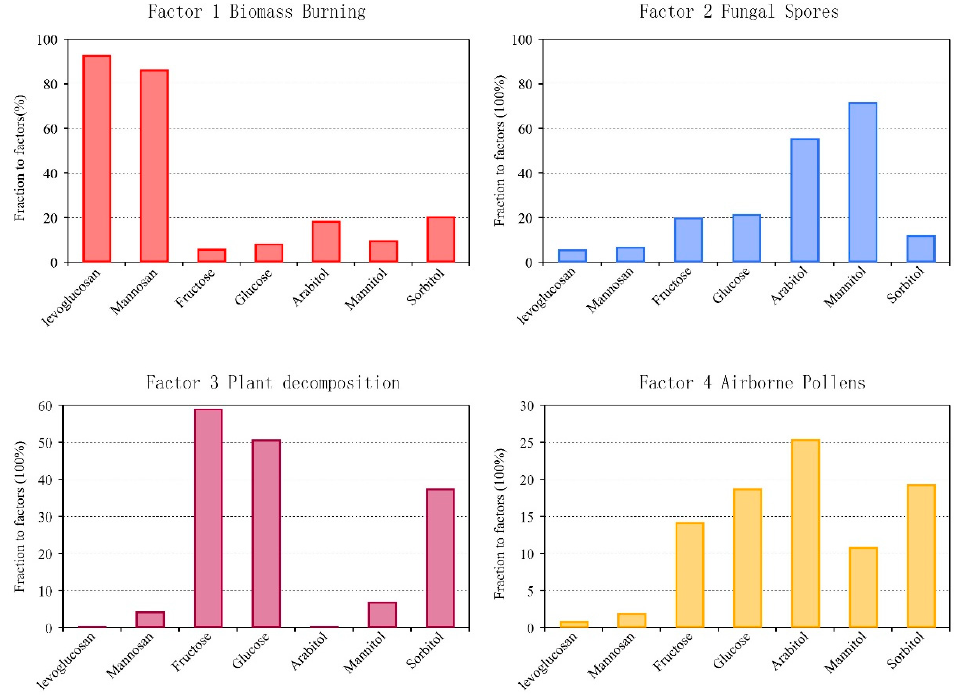
Figure 5. Positive matrix factorization (PMF) factor analysis of saccharides in Shanghai in 2013.